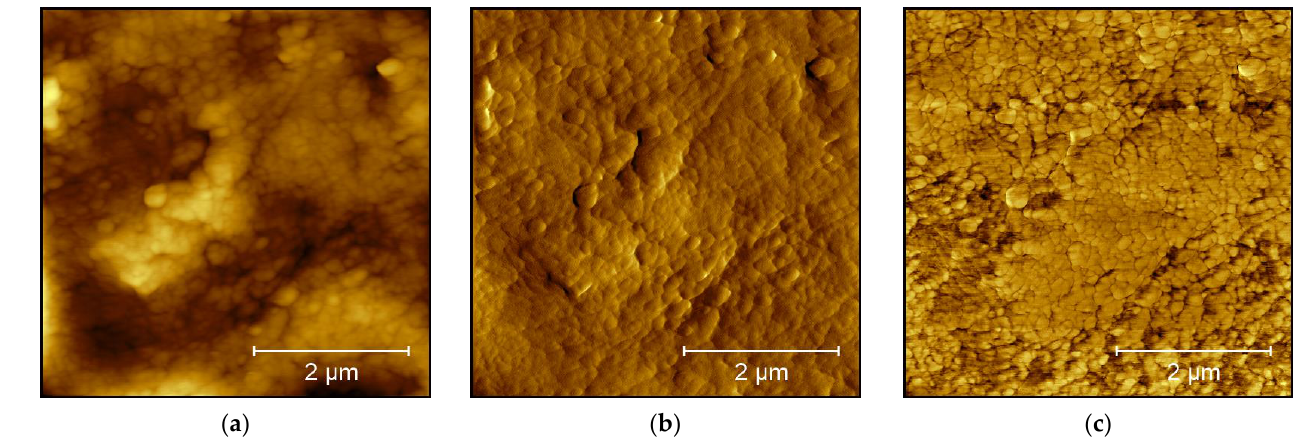
Figure 8. AFM images of a 3D printed PLA “temp” surface: ( a ) topography (height range 154 nm); ( b ) amplitude; ( c ) phase image (phase range 16°).